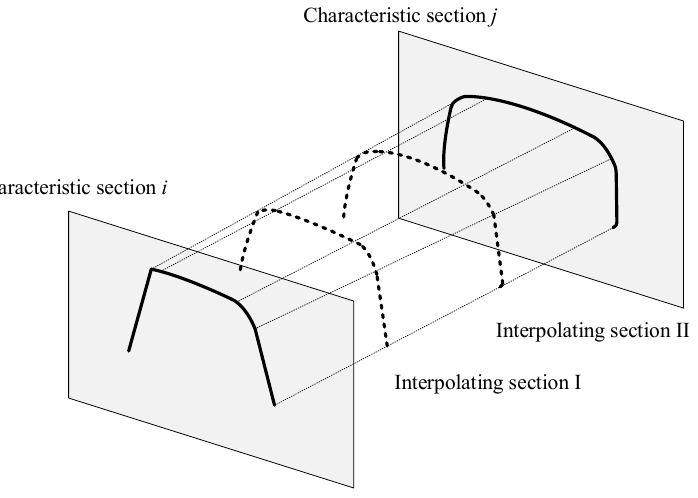
Figure 2. Transition between characteristic sections.